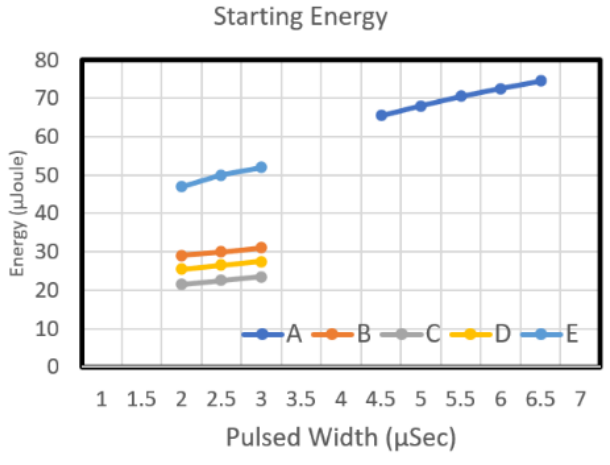
Figure 9. The initial energy diagrams of chip number A,B,C,D,E type.